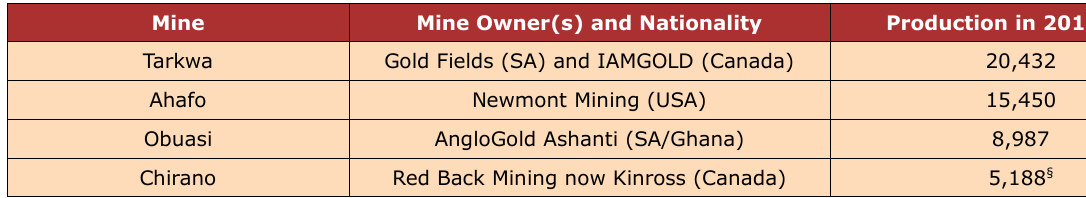
Table 2. Selected Large Scale Mines in